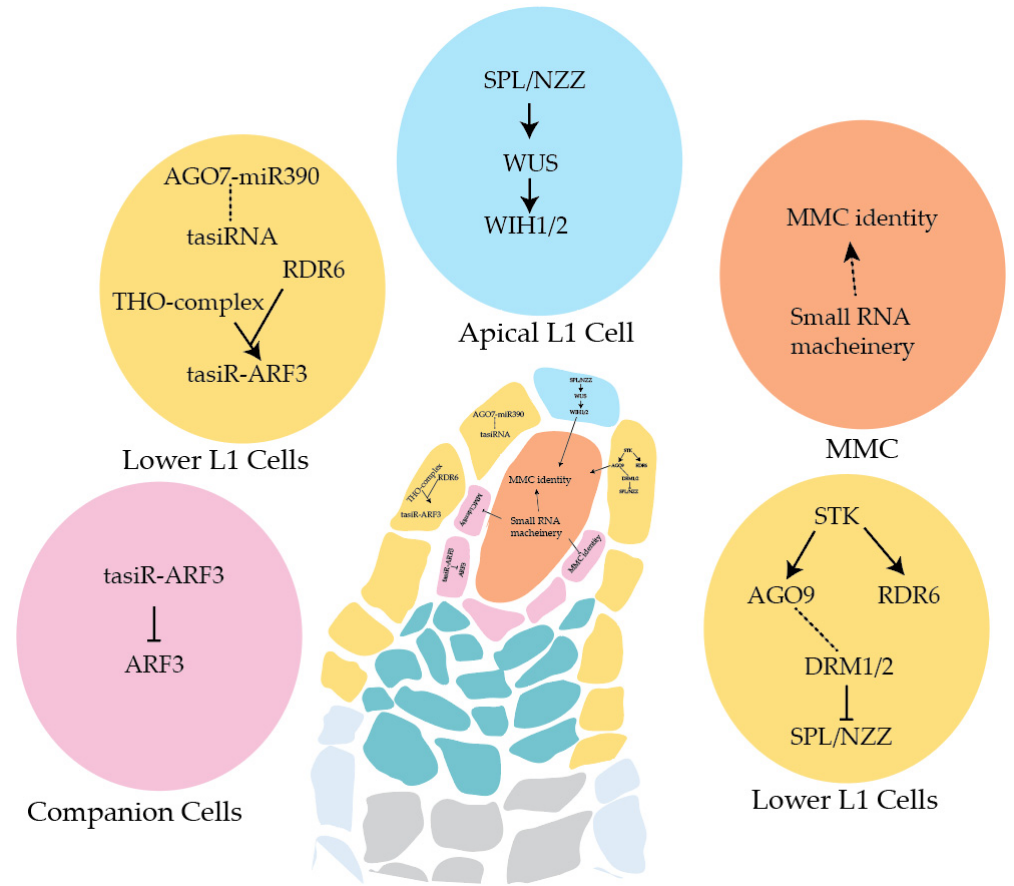
Figure 4. Summary of key pathways involved in female germline differentiation. The distinct processes in the megaspore mother cell (MMC, orange), the companion cells (pink), the apical L1 cell (blue) and the lower L1 cells (yellow) are represented in the Arabidopsis ovule. The cell-specific small RNA-dependent pathways are required to develop MMC fate and ovule development.